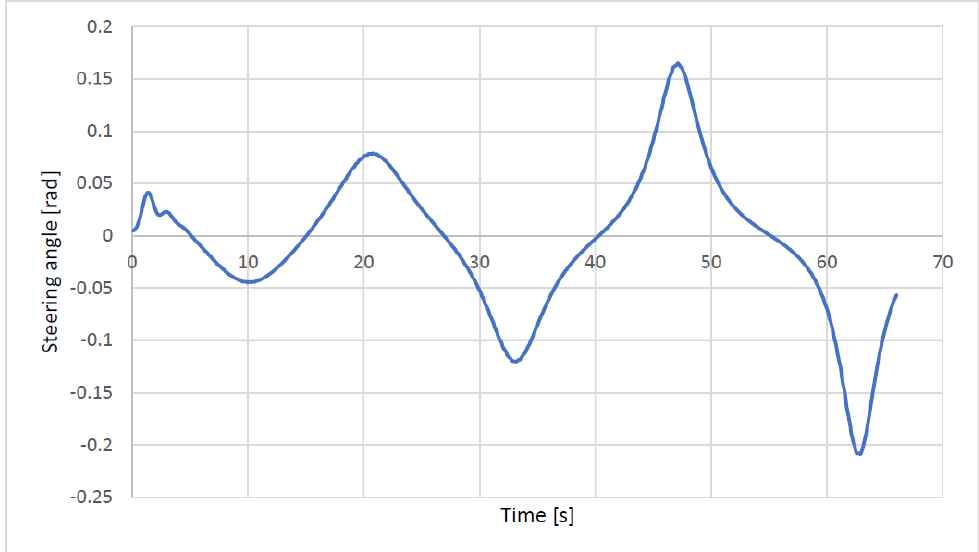
Figure 10. Steering angle of the simulated trajectory.